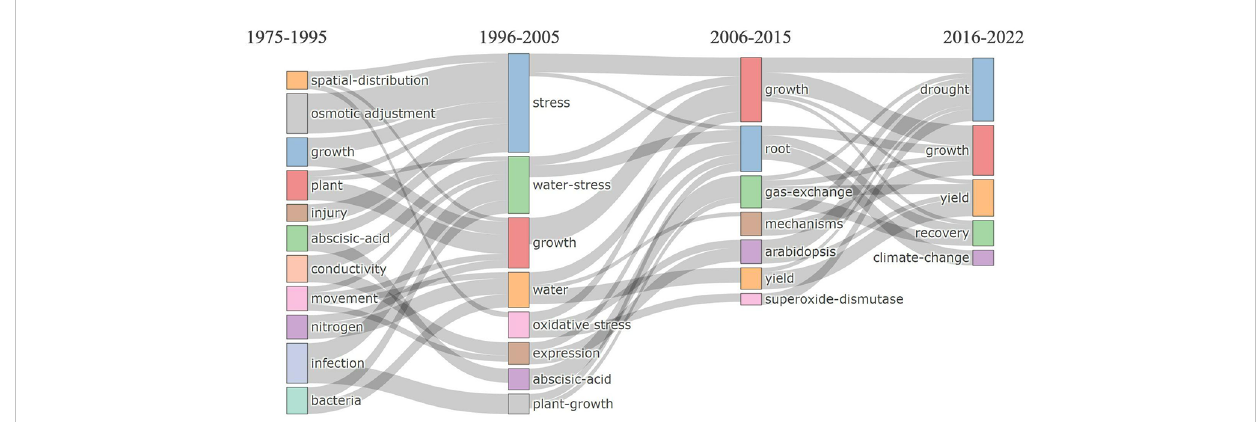
FIGURE 4 Thematic evolution of popular keywords in regard to root plasticity during drought and recovery research. The horizontal axis represents the time period, and boxes of different colors represent different keywords. The size of each box represents the frequency in different time periods, and the lines between each box re fl ect the keywords ’ temporal evolution, transfer, and